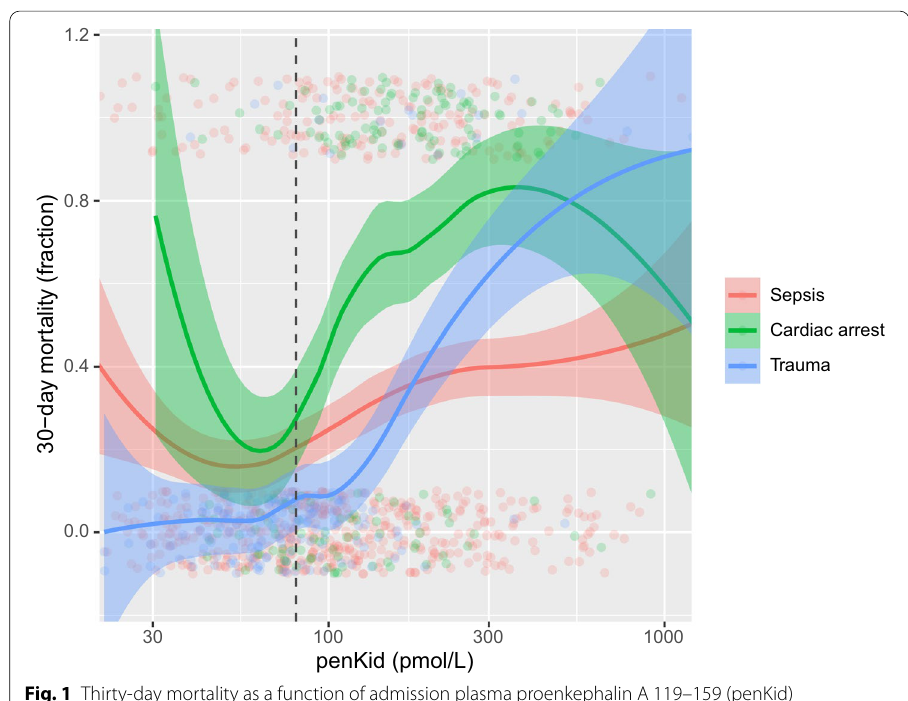
Fig. 1 Thirty-day mortality as a function of admission plasma proenkephalin A 119–159 (penKid) concentration in the subgroups sepsis, cardiac arrest and trauma. The vertical line at penKid 80 pmol/L is the upper normal (99th percentile) limit. The continuous lines represent smoothed averages, i.e. the average 30-day mortality in a small neighbourhood of a penKid value. The coloured bands around the smoothed averages indicate 95% confidence bands. Individual patients are represented by dots with jitter added. Thus, y values in the interval ( 0.1, 0.1) represent survivors (0 with added jitter), and y values in the interval (0.9,1.1) − represent non-survivors (1 with added